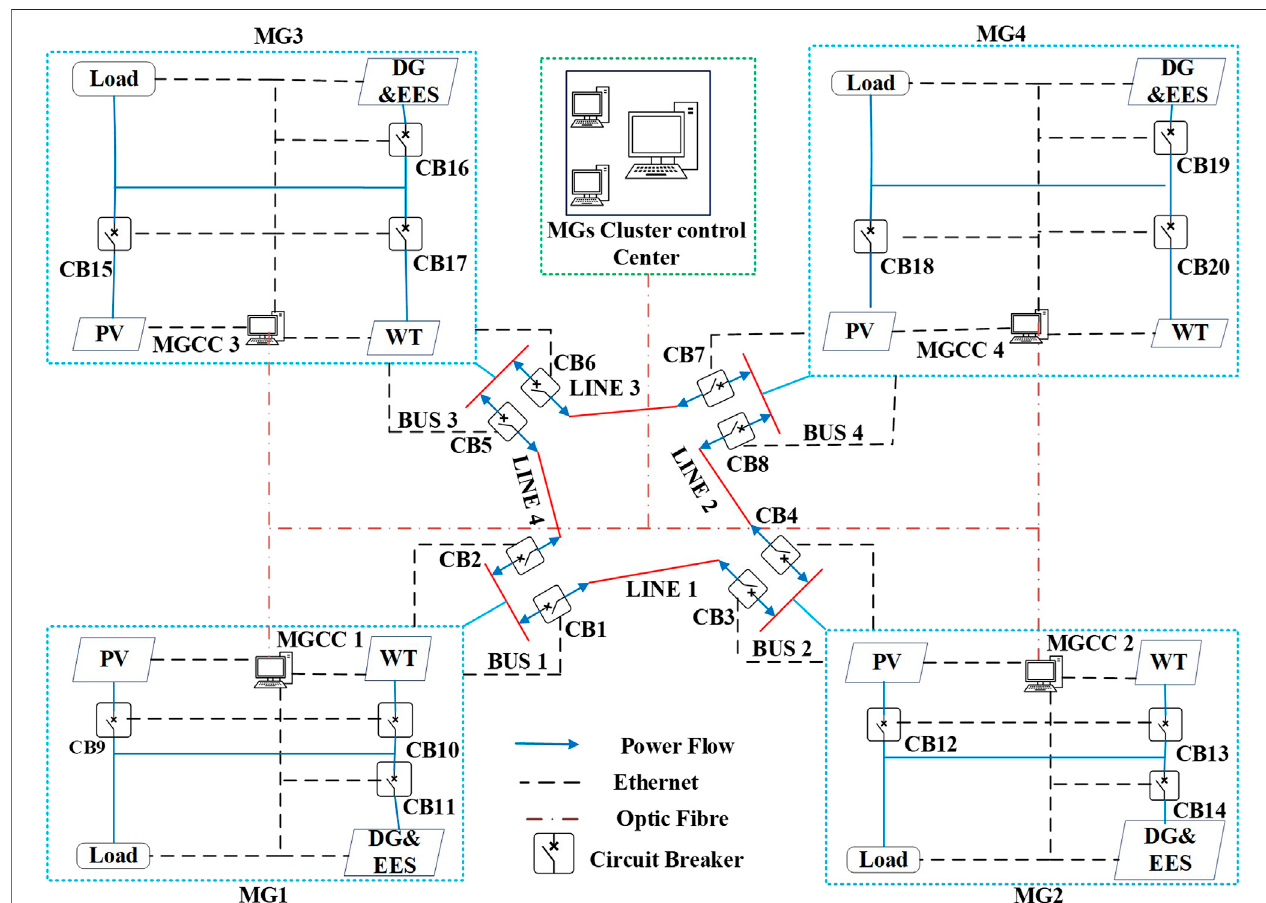
FIGURE 1 | Typical structure of